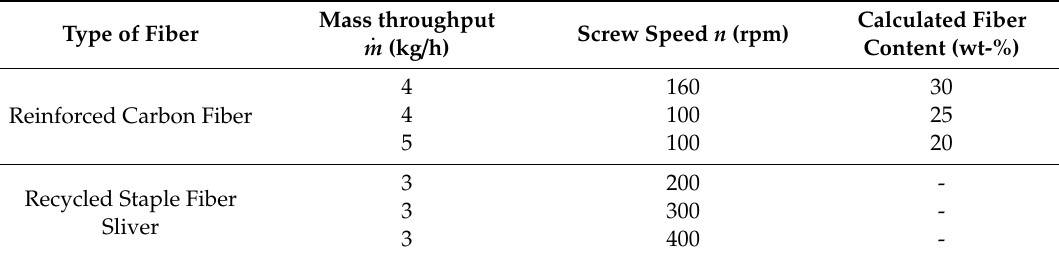
Table 3. Settings of the preliminary tests.